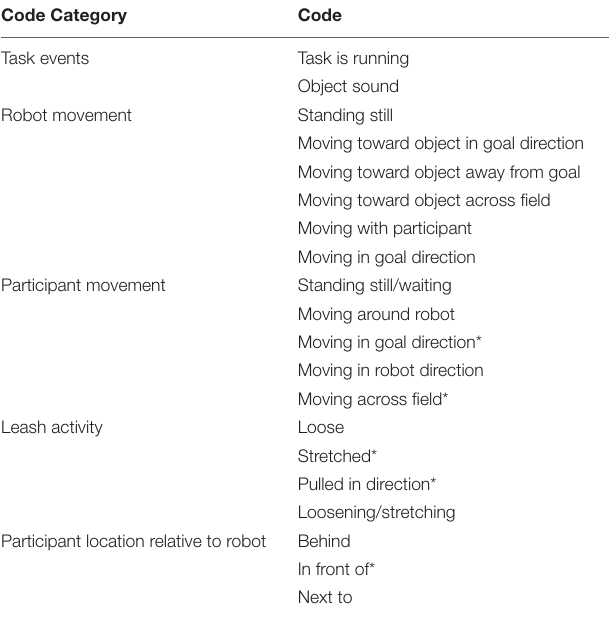
TABLE 4 | The coding scheme that was developed to analyze the behavior of participants and the robot in the